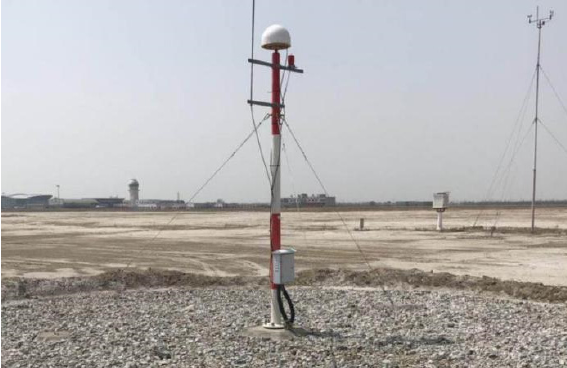
Figure 10. BDS GBAS antenna mounted on the ground near the runway at the Dongying Airport in Shandong, China.